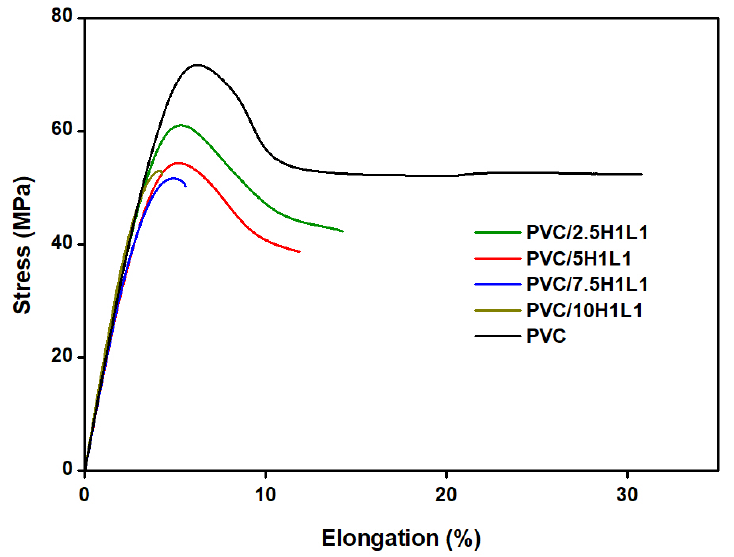
Figure 9. Representative stress–strain curves from the tensile test for the PVC and PVC composites with various concentrations of halloysite–lignin hybrid filler (1:1 wt/wt). Table 5. Mechanical properties of PVC and PVC composites with halloysite, lignin and halloysite–lignin hybrid fillers.